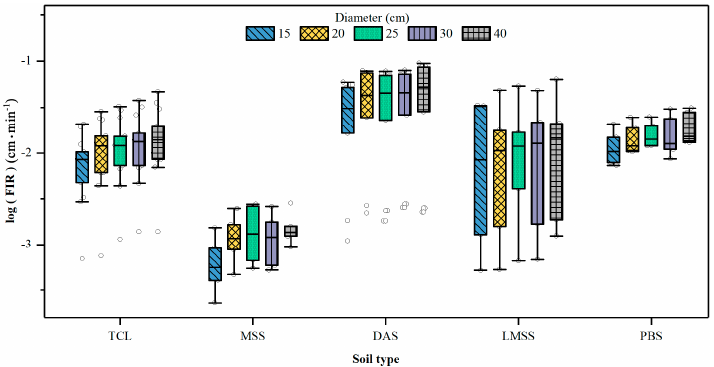
Figure 5. Distribution of the simulated log-transformed final infiltration rate (FIR) with different inner-ring diameters for five soil types.